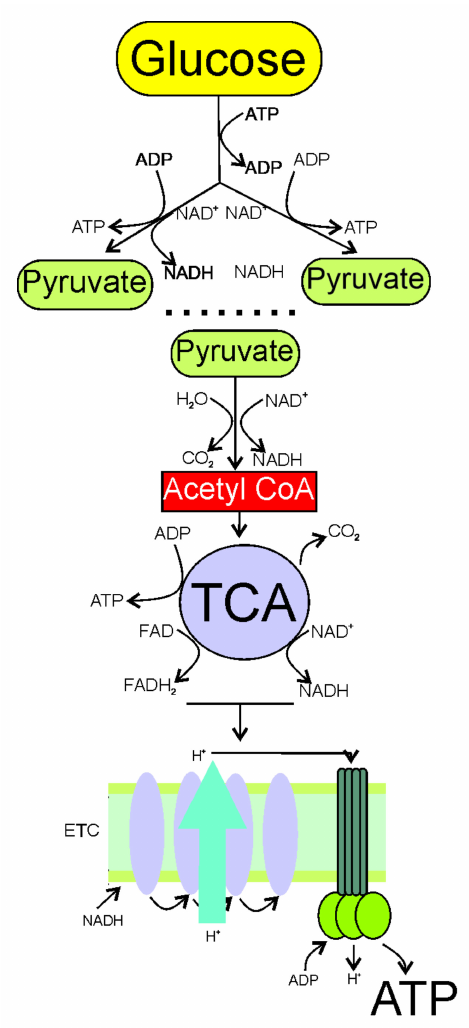
Figure 1. Synthesis of ATP from glucose, the main process of energy production in the brain, consists of three essential stages: glycolysis; the citric acid cycle (TCA); and oxidative phosphorylation. Glycolysis occurs in the cytoplasm, and uses ATP to split glucose into two pyruvate molecules. This process gives a net gain of two ATP molecules. In an aerobic environment, each pyruvate becomes acetyl CoA (acetyl coenzyme A), and goes to the mitochondria matrix to perform the TCA cycle, resulting in the production of CO 2 , NADH (nicotinamide adenine dinucleotide), FADH 2 (dihydroflavine adenine dinucleotide), and ATP. The generation of coenzymes NADH and FADH 2 is critical, as they donate electrons and hydrogen to ETC in the inner mitochondrial membrane within the cristate to produce more ATP—one molecule of glucose gives 36 ATP